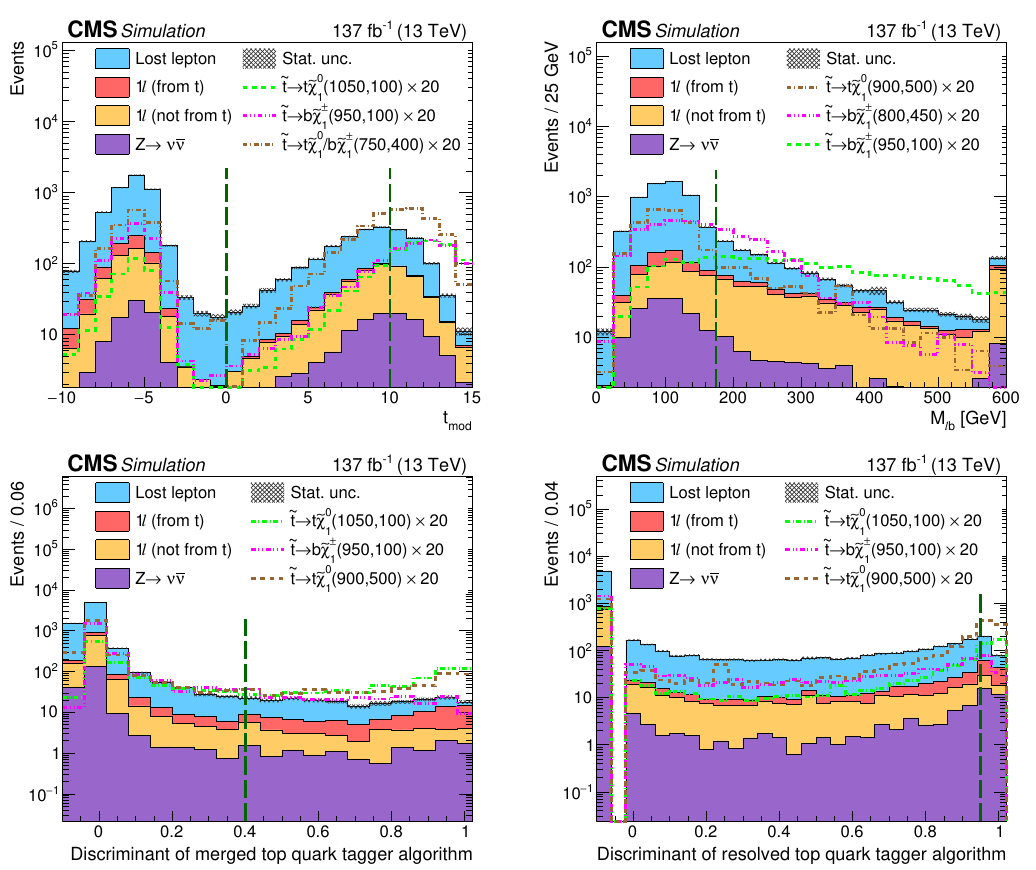
Figure 3 . The distributions of t (upper left), M ‘ (upper right), the merged top quark tagging mod b discriminant (lower left), and the resolved top quark tagging discriminant (lower right) are shown after the preselection requirements. The green, dashed vertical lines mark the locations of the binning or tagging requirements. The stacked histograms showing the SM background contributions (categorized as described in section 5) are from the simulation to illustrate the discriminating power of these variables. The gray hashed region indicates the statistical uncertainty of the simulated samples. Events outside the range of the distributions shown are included in the (cid:12)rst or last bins. The expectations for three signal hypotheses are overlaid, and the corresponding numbers in parentheses in the legends refer to the masses of the top squark and neutralino, respectively. For models with